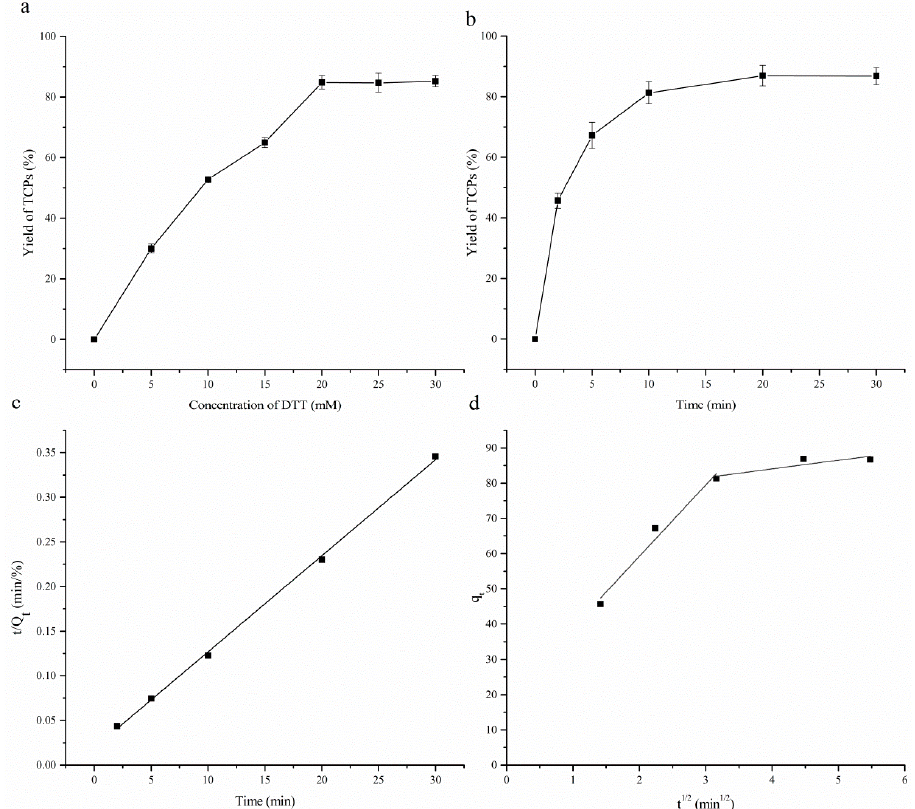
Figure 4. ( a ) Effect of concentration of DTT on the desorption yield of TCPs; ( b ) effect of incubating time on the desorption yield of TCPs; ( c ) plots of pseudo-second order kinetic model for the desorption of TCPs; ( d ) plots of the Weber-Morris intra-particle diffusion for the desorption of